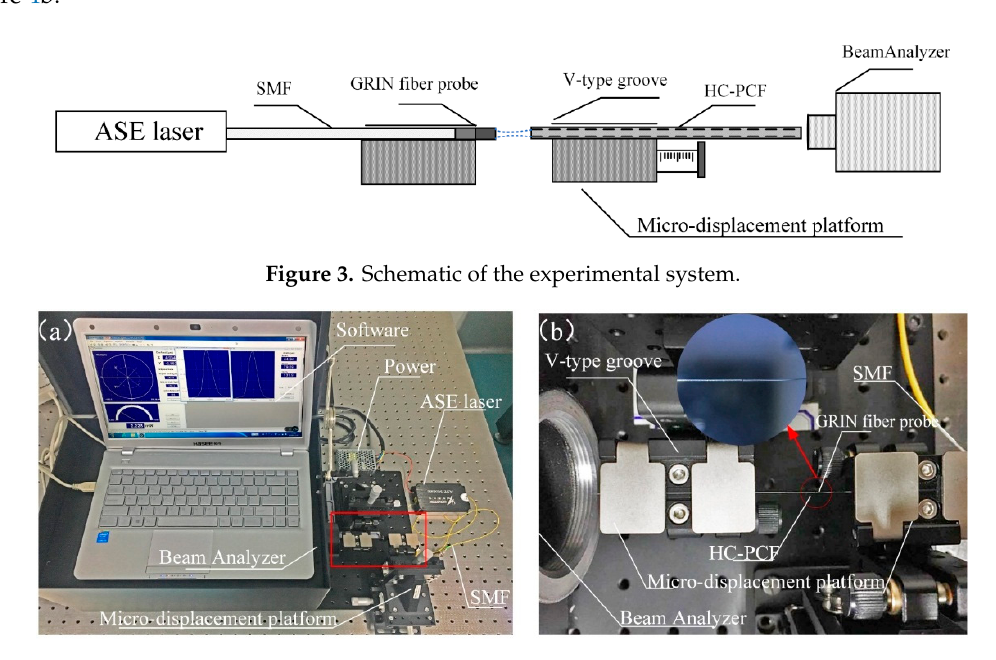
Figure 4. Coupling efficiency testing system: ( a ) Experimental system setup; ( b ) detail of coupling part.